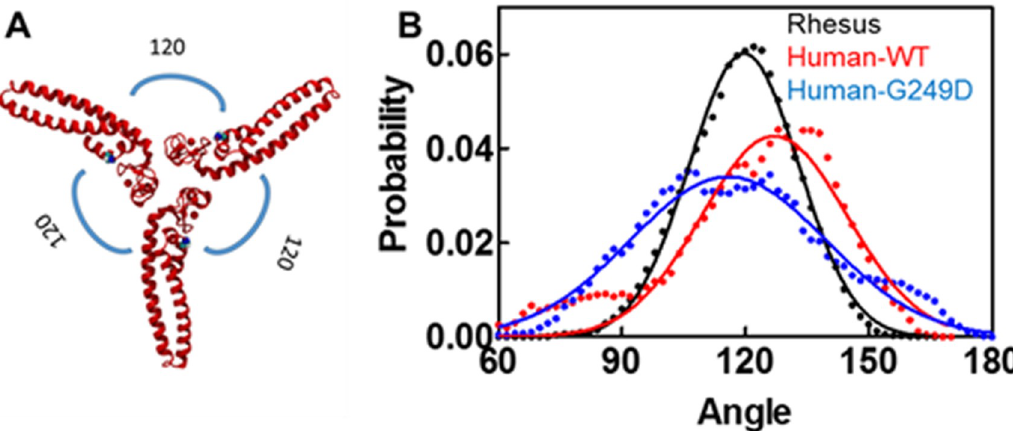
Fig 6. Human WT and G249D Bcc miniTRIM oligomers exhibit wider angle distributions than rhesus miniTRIM. (A) Rhesus Bcc miniTRIM structure with representative angles. (B) Probability distribution of angles for rhesus (in black), human WT (in red) and G249D (in blue) Bcc miniTRIMs obtained from MD simulations of our homology models (circles) and Gaussian fits (solid lines). The angles are defined by the angle between C α atoms of residues 117 and 174 for rhesus and 115 and 172 for human oligomers and gated for 2 degrees to obtain frequency